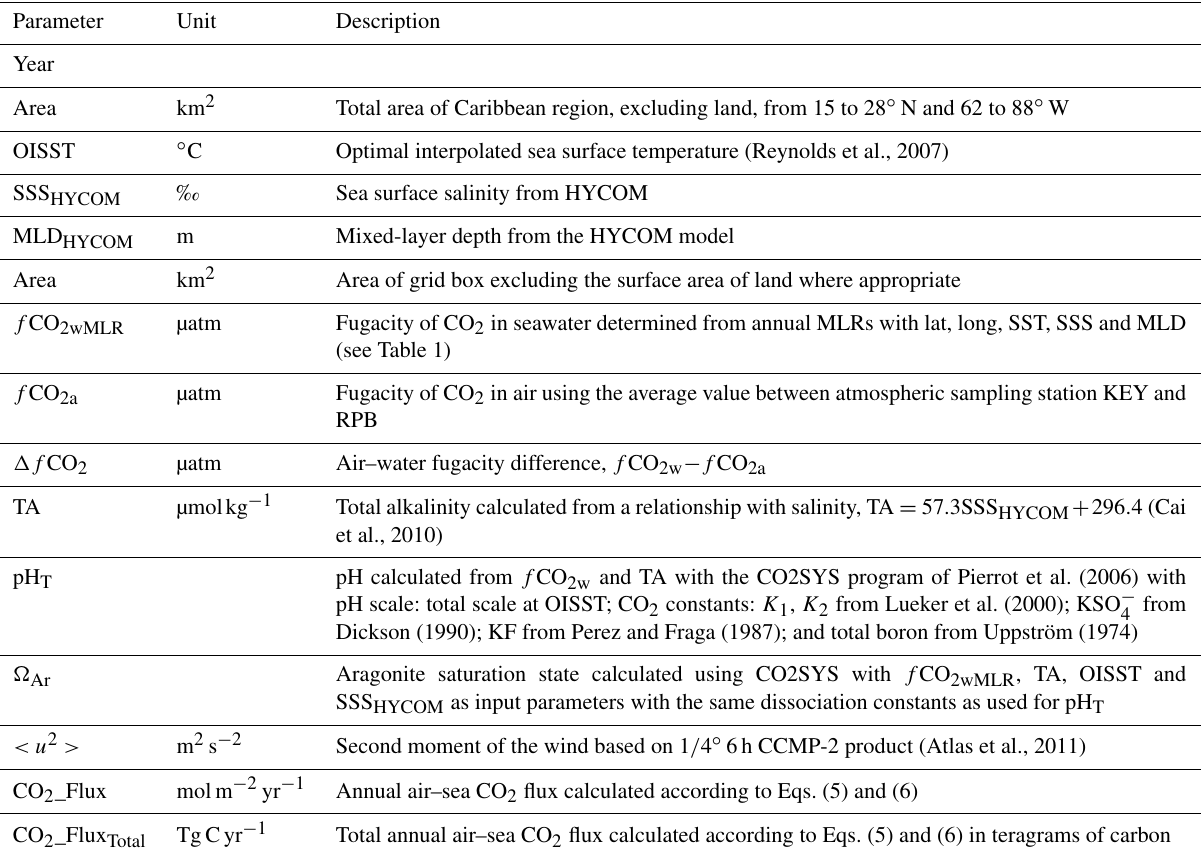
Table 6. Column headers, units and description for the annual averaged mapped product. Parameter Unit Description Year Area km 2 Total area of Caribbean region, excluding land, from 15 to 28 ◦ N and 62 to 88 ◦ W Optimal interpolated sea surface temperature (Reynolds et al., 2007) Sea surface salinity from HYCOM Mixed-layer depth from the HYCOM